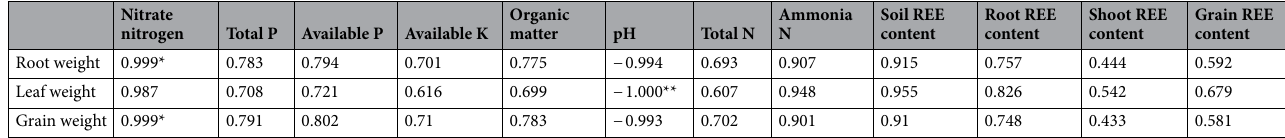
Table 3. Pearson correlation of rare earth element content, soil physical and chemical properties and dry weight of root, shoot and grain of rice. **At 0.01 level (two tailed), the correlation was significant, *At 0.05 level (two tailed), the correlation was significant, n =